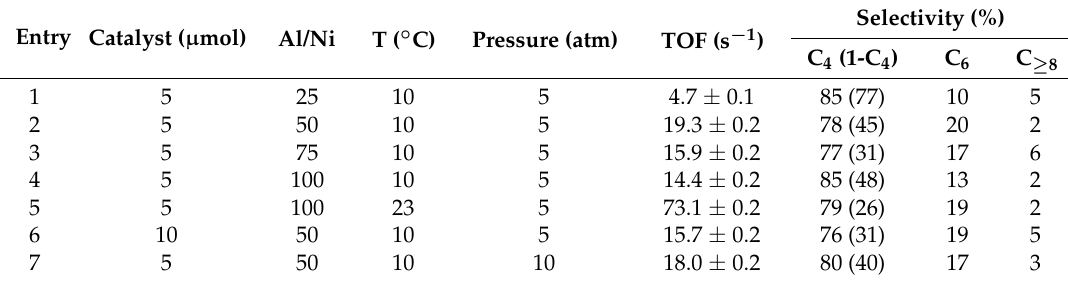
Table 4. Activity and selectivity in homogeneous catalytic